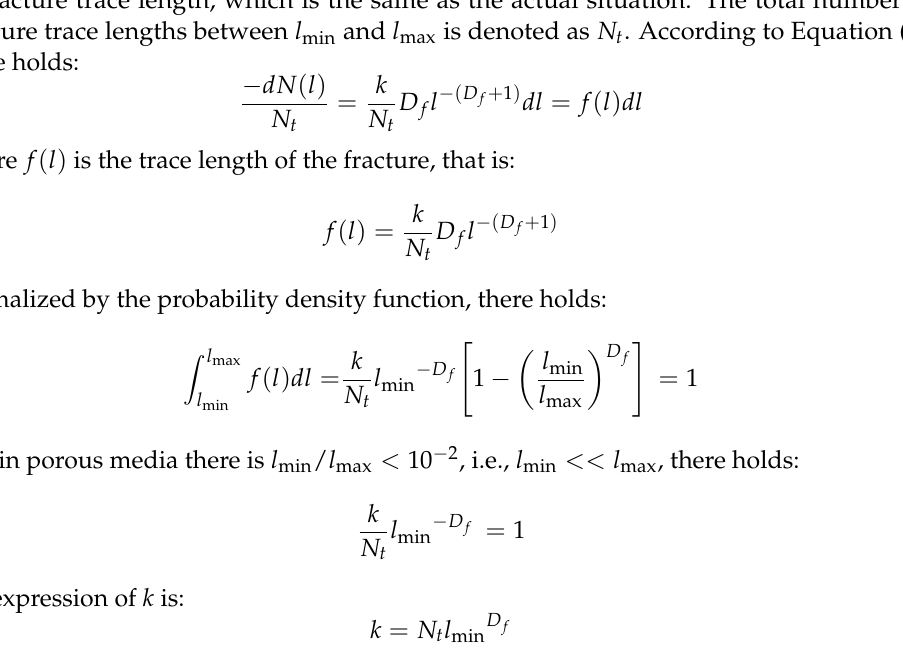
Figure 3. Model characterization of a single capillary bundle.